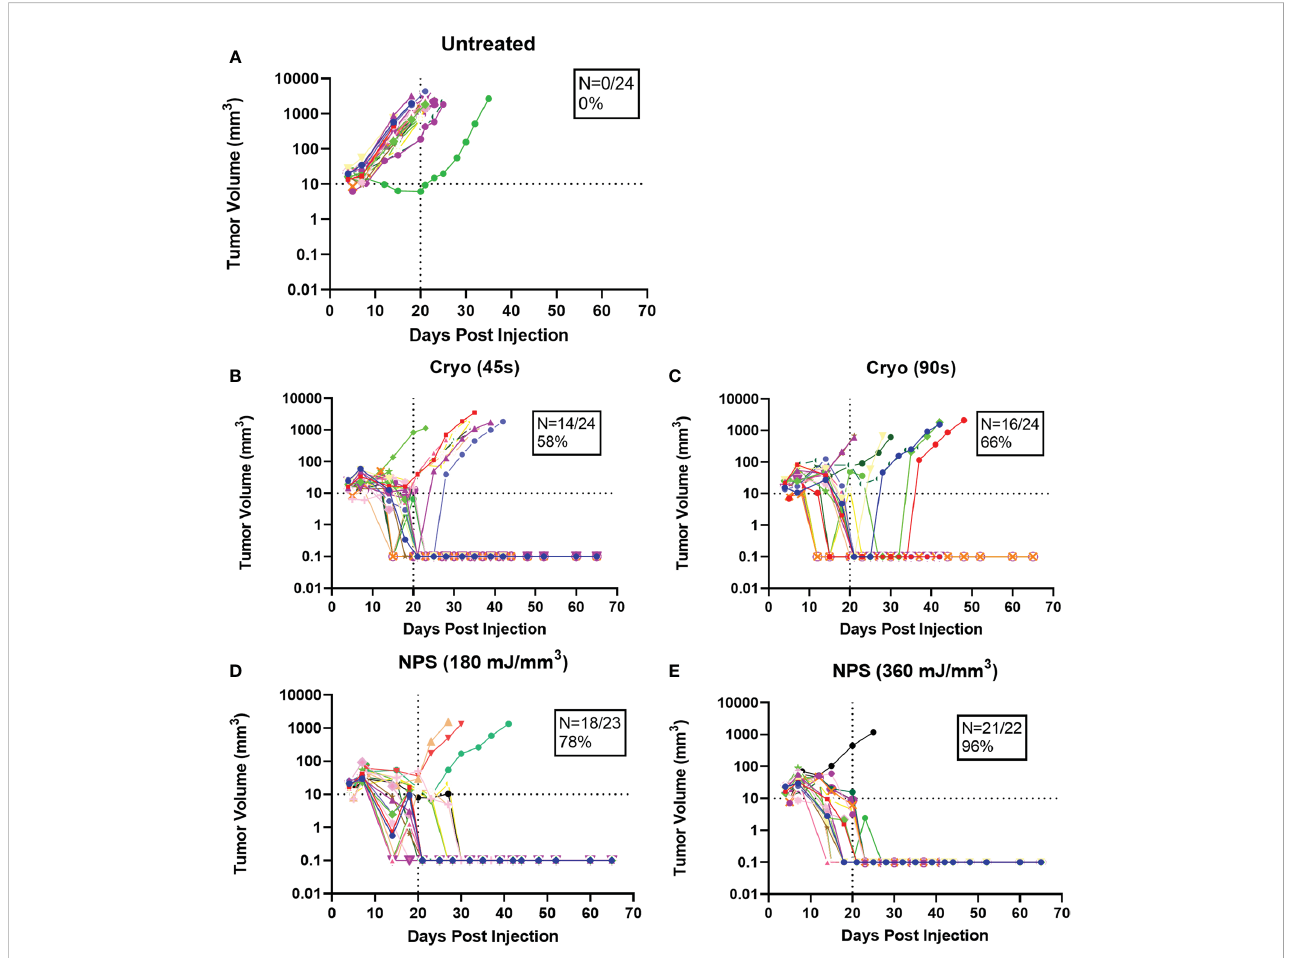
FIGURE 3 Growth rates of individual tumors treated with the treatment indicated above each graph. Each color represents a single tumor. N represents the percentage of tumors completely cleared in each case (A) Untreated; (B) Cryo (45s); (C) Cryo (90s); (D) NPS (180 mJ/mm3); (E) NPS (360